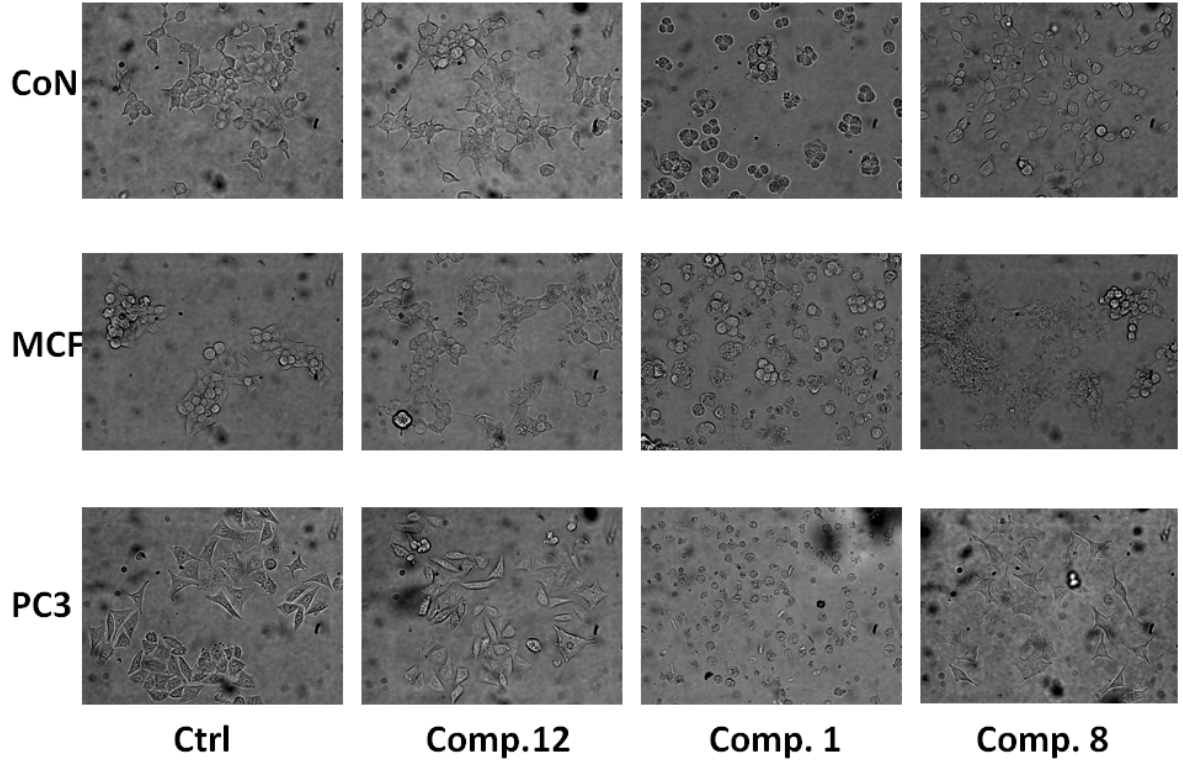
Figure 3. Effect of tested compounds on the morphologies of CoN, MCF-7 and PC-3 cells. Images obtained with an inverted phase contrast microscope (200×) after 24 h exposure of the cells to 50 μ M of compounds 1 , 8 , and 12 . (1% ethanol) and similar to control positive (5-fluorouracil,